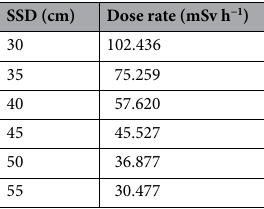
Table 1. The amounts of SSDs for 90 Sr and corresponding dose rates.